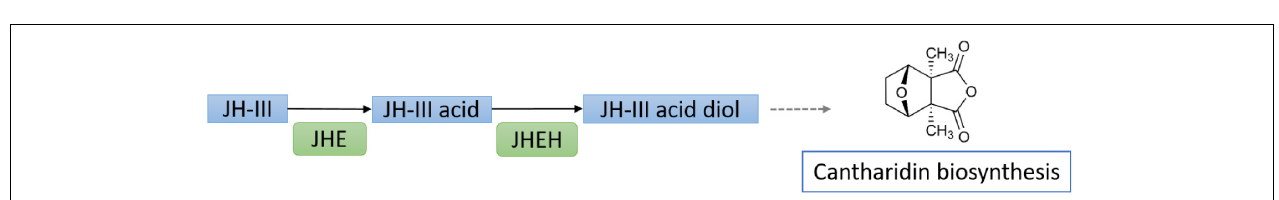
FIGURE 6 | Schematic diagram showing the mechanisms of sesquiterpenoids in regulation of insect eusociality. (A) The effect of JH on reproduction and polyethism in ants. The elevation of JH represses ovary development in simple, queenless societies but promotes queen production and vitellogenin expression in complex societies. JH also induces threat responsiveness and reduces interest in intraida works in ants, and may also increase their body size. (B) The effect of JH on reproduction and polyethism in wasps. JH generally stimulates the production of queens and ovary development, and mediates cuticular hydrocarbon blend resembling reproductive status in young workers of swarm-founding wasps. Besides, JH triggers the guarding and foraging behavior. (C) The queen releases QMP which downregulates JH and Kr-h1 and thus inhibits ovary development of workers and the transition from in-hive worker to forager in bees. (D) The increase of JH in JH-Met signaling pathway induces TGF β and 20E signals that promote the modification molts from worker to soldier in the sterile caste of termite Z . nevadensis .